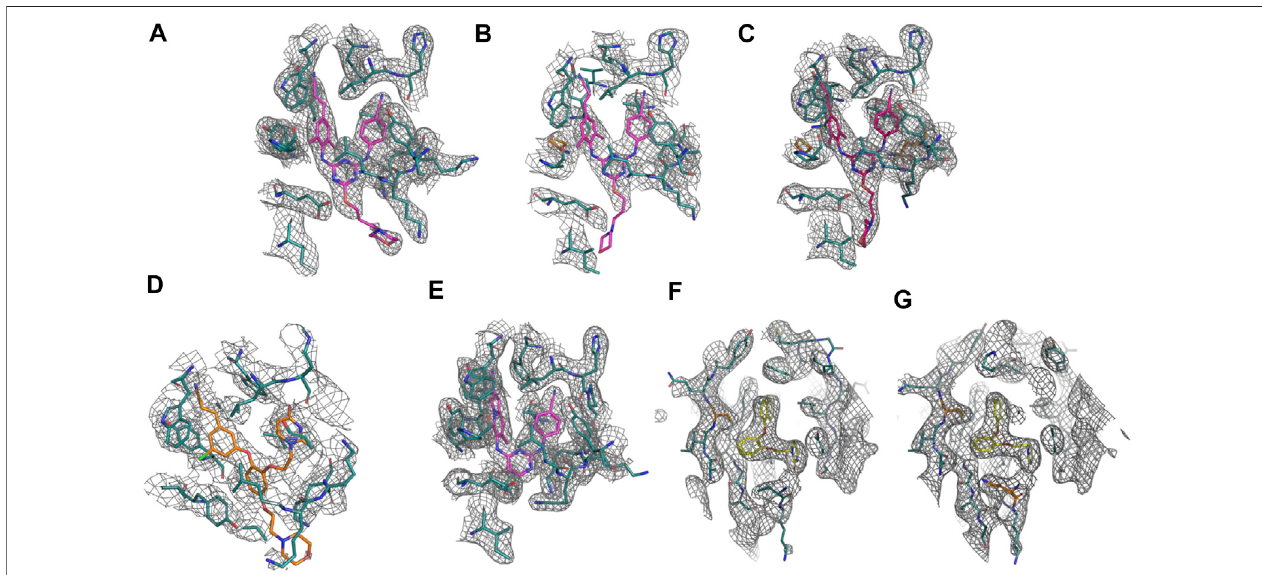
FIGURE 2 | Omit electron density of the non-nucleoside inhibitor binding site for all crystal structure complexes: (A) RT (WT): 2 . (B) RT (Y181C): 2 . (C) RT (K103N/ Y181C): 2 . (D) RT(WT): 1 . (E) RT(WT): 4 . (F) RT(Y181C): 3 . (G) RT(K103N/Y181C): 3. Omitelectrondensitymapsweregeneratedusingsimulatedannealingomitbuildin Phenix (Adams et al.,